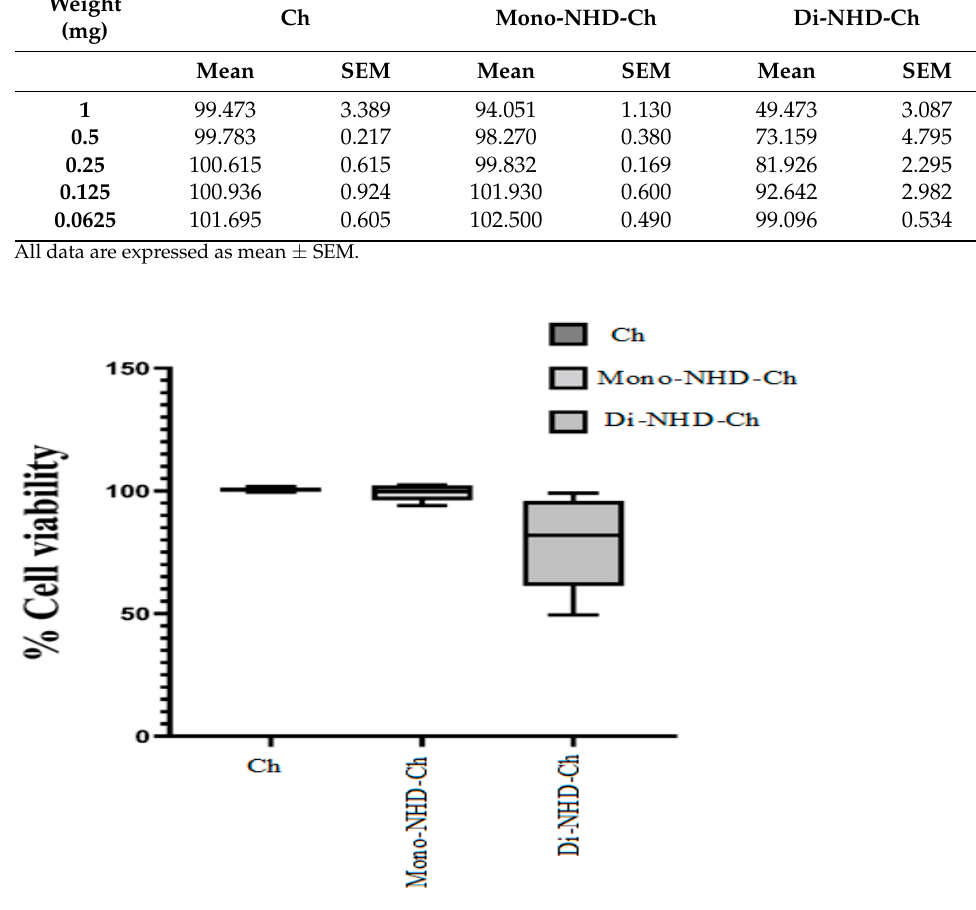
Figure 5. The percentage of Wi-38 cell viability after 72 h incubation with serial doses of Ch, Mono- NHD-Ch, and Di-NHD-Ch.